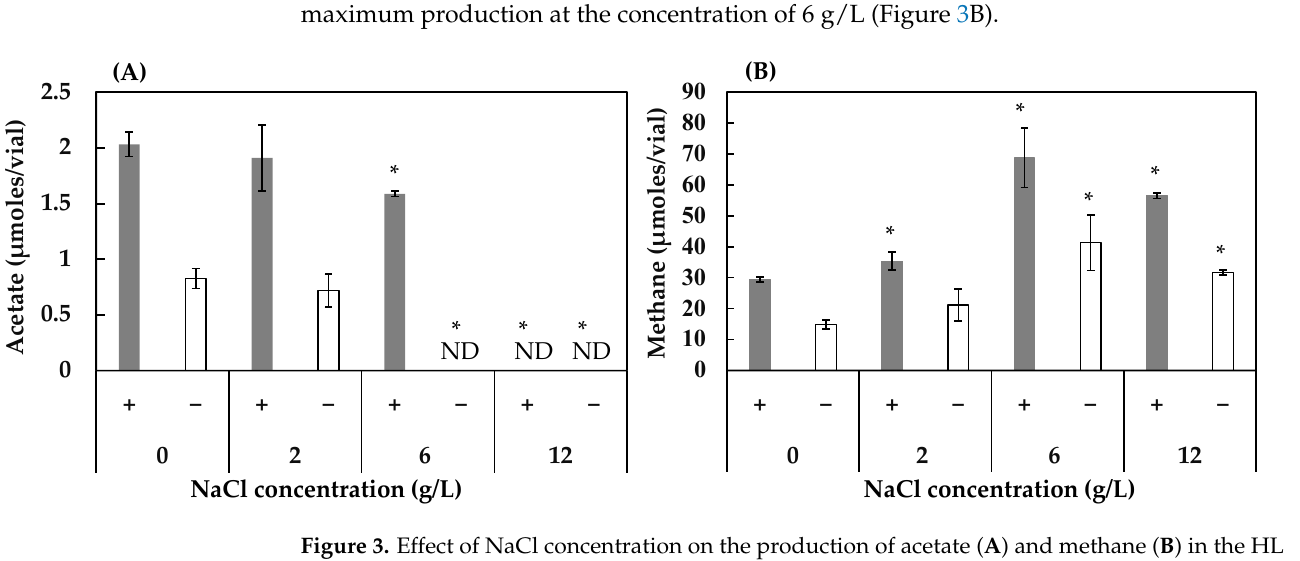
Figure 3. Effect of NaCl concentration on the production of acetate ( A ) and methane ( B ) in the HL consortium in the presence (+) and absence ( − ) of humin. The conditions with 0 g/L of NaCl are the same as conditions 4 (with humin) and 2 (without humin) in Figure 1. Vertical bars represent the standard deviation. Acetate and methane production with various NaCl concentrations were compared to those under the condition of 0 g/L of NaCl using the independent t -test. * represents a significant difference at p < 0.05. ND: not detected.